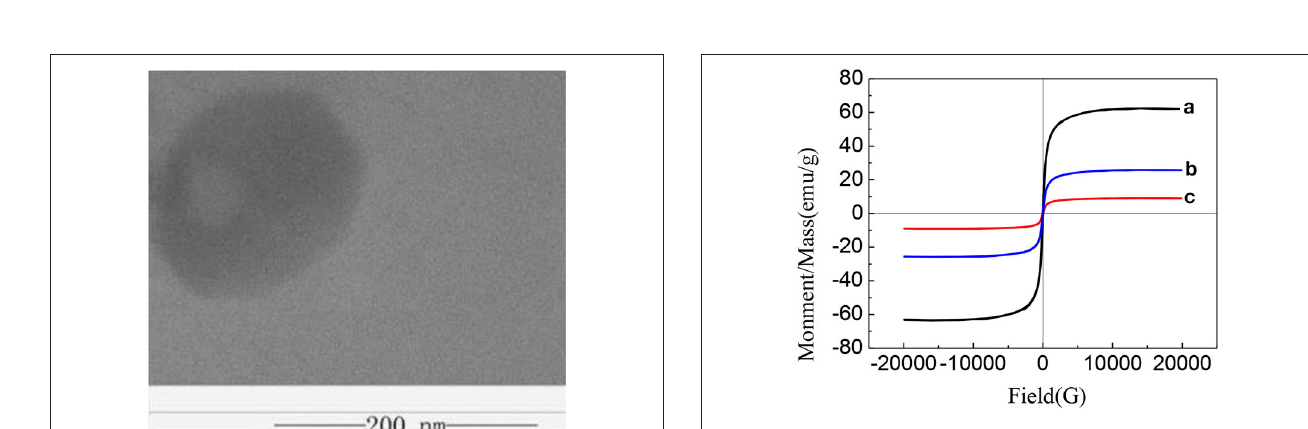
Table 1 shows the wet weight and dry weight of the obtained coagulated blood clot due to the interaction between PLA-combined Fe 3 O 4 -GO-ASA nanobubbles with different concentrations and blood samples. It can be seen from Table 1 that the wet weight of the normal saline control group was 95.10 ± 0.22 mg, while the wet weights for the composite nanobubbles with the concentrations of 20, 40, 60, 80, and 100 mg · mL − 1 were, respectively, 87.27 ± 0.16 mg, 75.73 ± 0.47 mg, 56.57